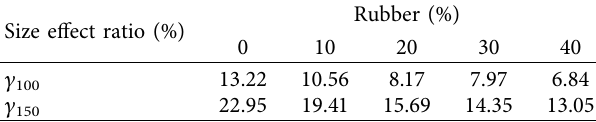
Table 3: Size effect ratio of rubber